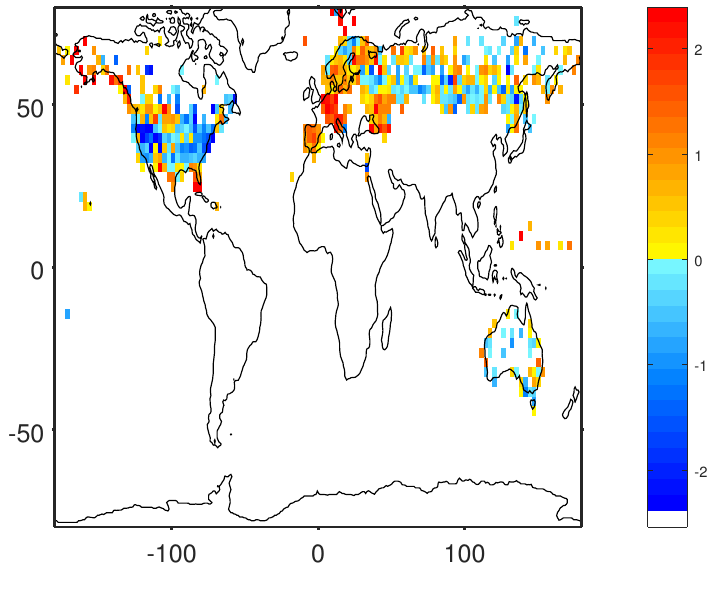
Figure 7. Map of recent (2012–2016) anomalies in annual minimum temperature (°C), averaged on a 3°